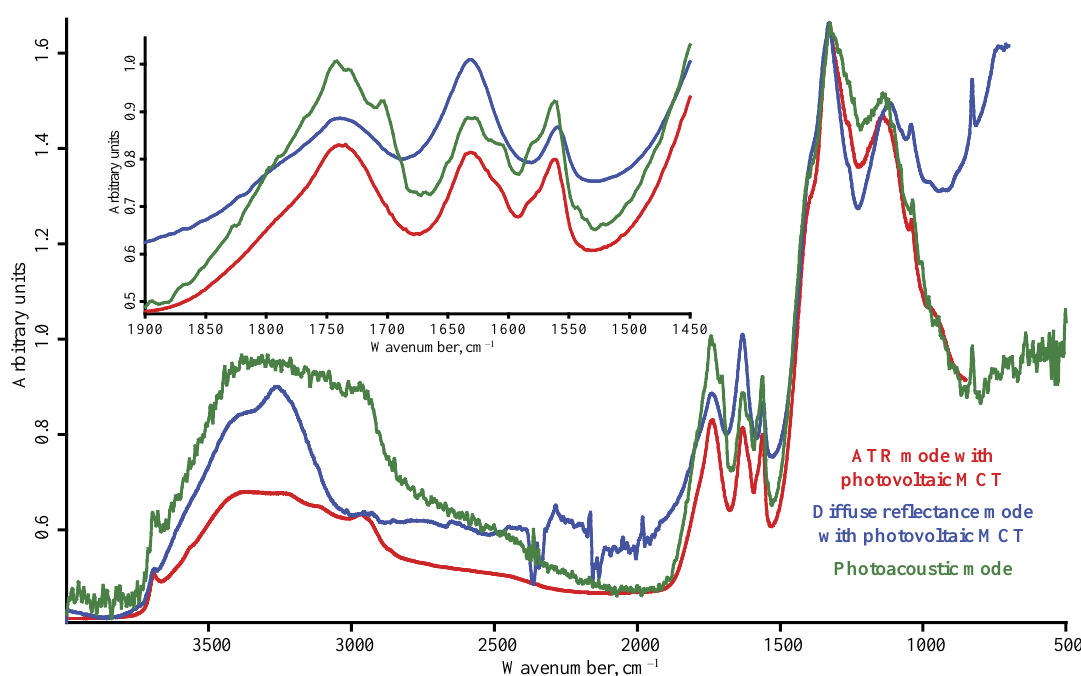
Figure 6. DNA-STP nanodiamonds; red, ATR mode with photovoltaic MCT detector; blue, diffuse reflectance mode with photovoltaic MCT detector; green, photoacoustic mode. Spectra are not smoothed but normalized to maximize each spectrum.